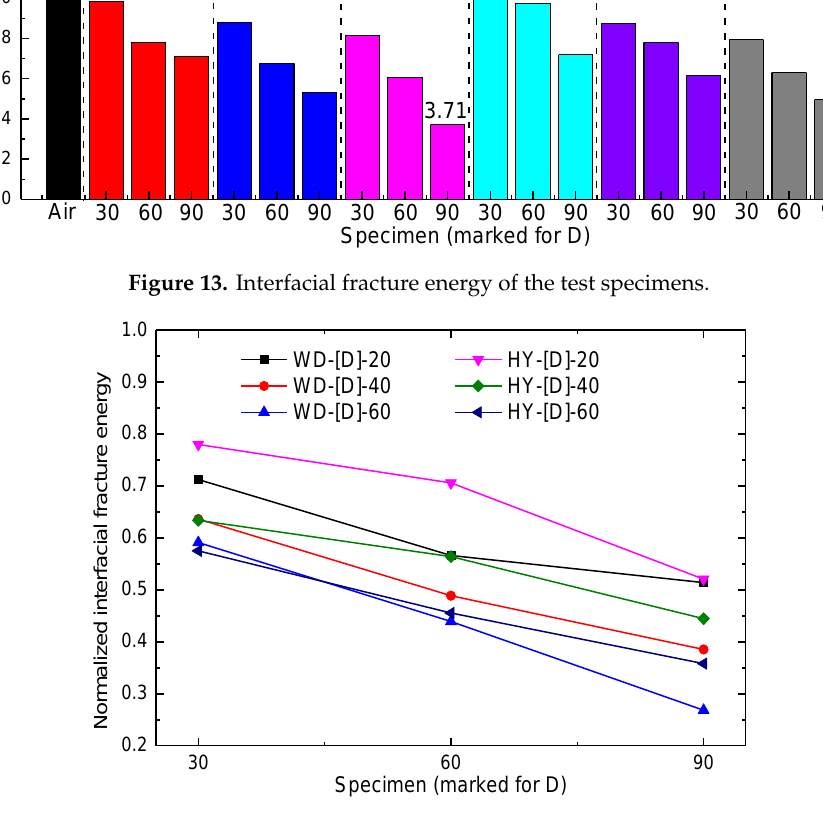
Specimen (marked for D) Figure 14. Normalized interfacial fracture energies of the cured specimens. Figure 14. Normalized interfacial fracture energies of the cured Figure 14. Normalized interfacial fracture energies of the cured specimens.